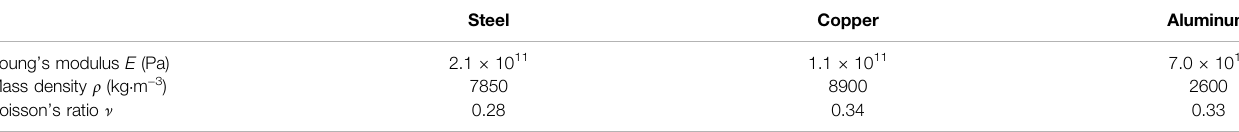
TABLE 2 | The material parameters of the homogeneous beam.